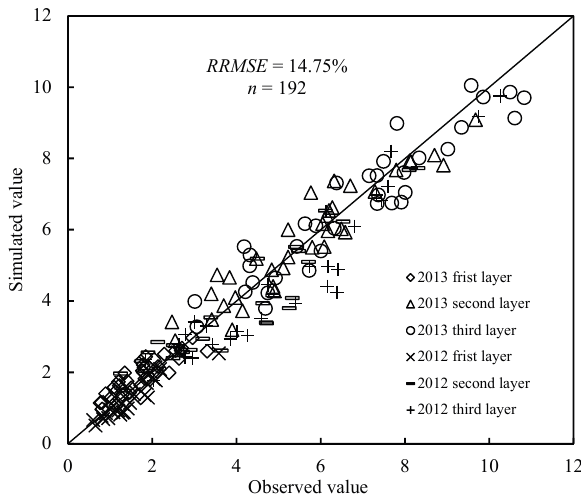
Figure 7. Comparison of simulated and observed downward cumulative LAI in rice, 2012 and